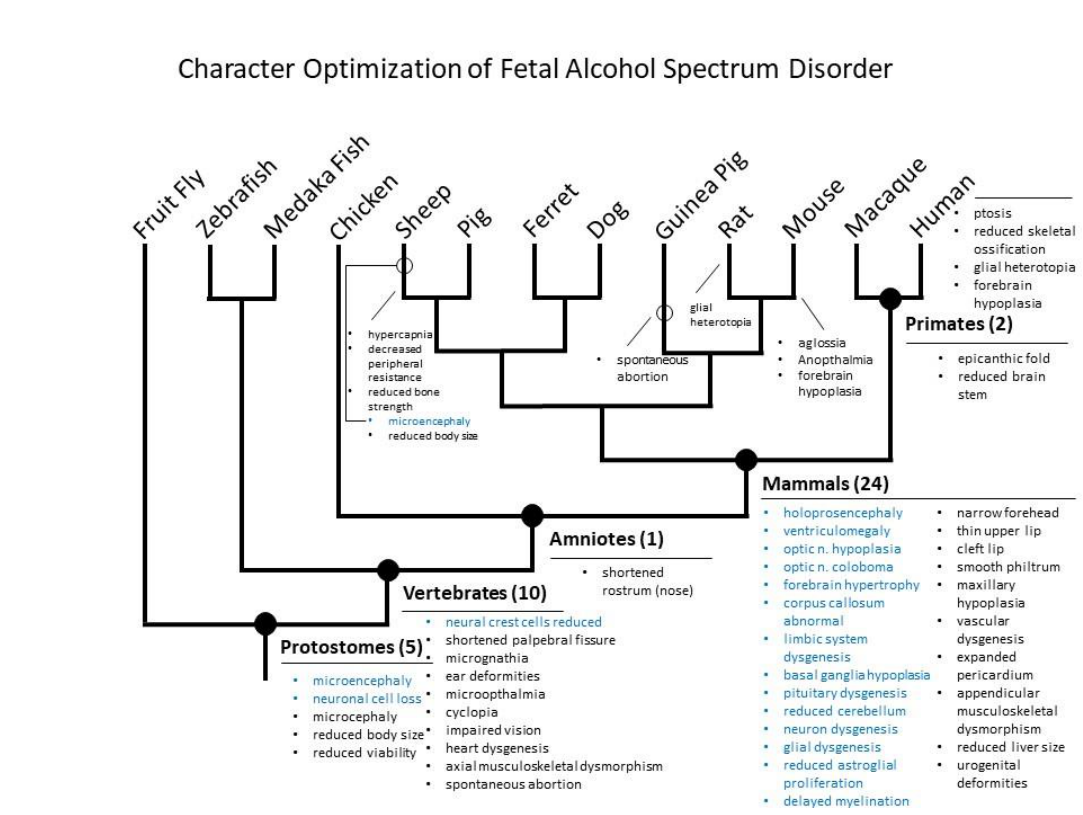
Figure 2. Character optimization – FASD Symptoms. FASD symptoms are most commonly attributed to Mammals, though there are symptoms that characterize each node within the clade of animals studied. Open circles indicate loss of a character. Neurological characters are listed in